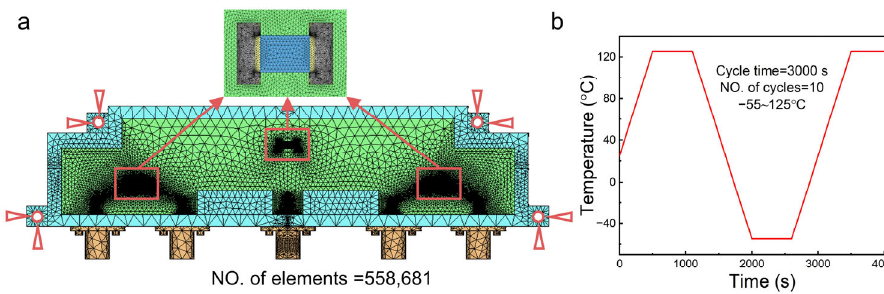
Figure 2. Pretreatment of finite element simulation: ( a ) Mesh generation and constraints; ( b ) Load files.